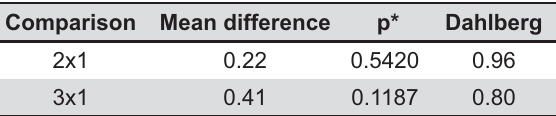
Table 2- Descriptive measurements and test of normality for method error (Wilcoxon) Comparison Mean difference